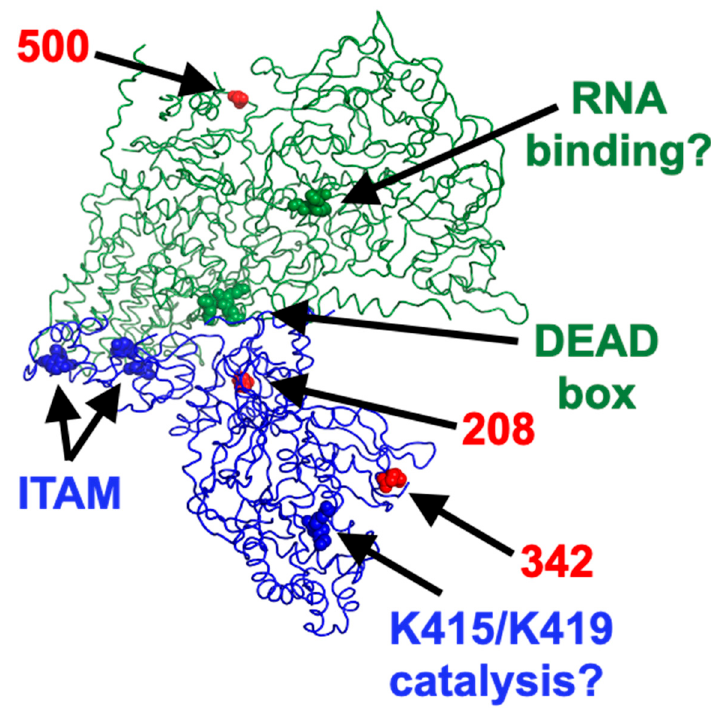
Figure 10. The structure was obtained from ncbi under the accession number 7elh. For simplicity a single molecule of both µ 2, in blue, and λ 1, in green is presented as ribbon structure and viewed from the core’s interior. Residues of interest are represented by spheres, as indicated and described in the text. Red spheres are the three residues of µ 2 and λ 1 that differ between T3D S and T3D K . The figure was prepared using PyMOL© version 2.5.1.